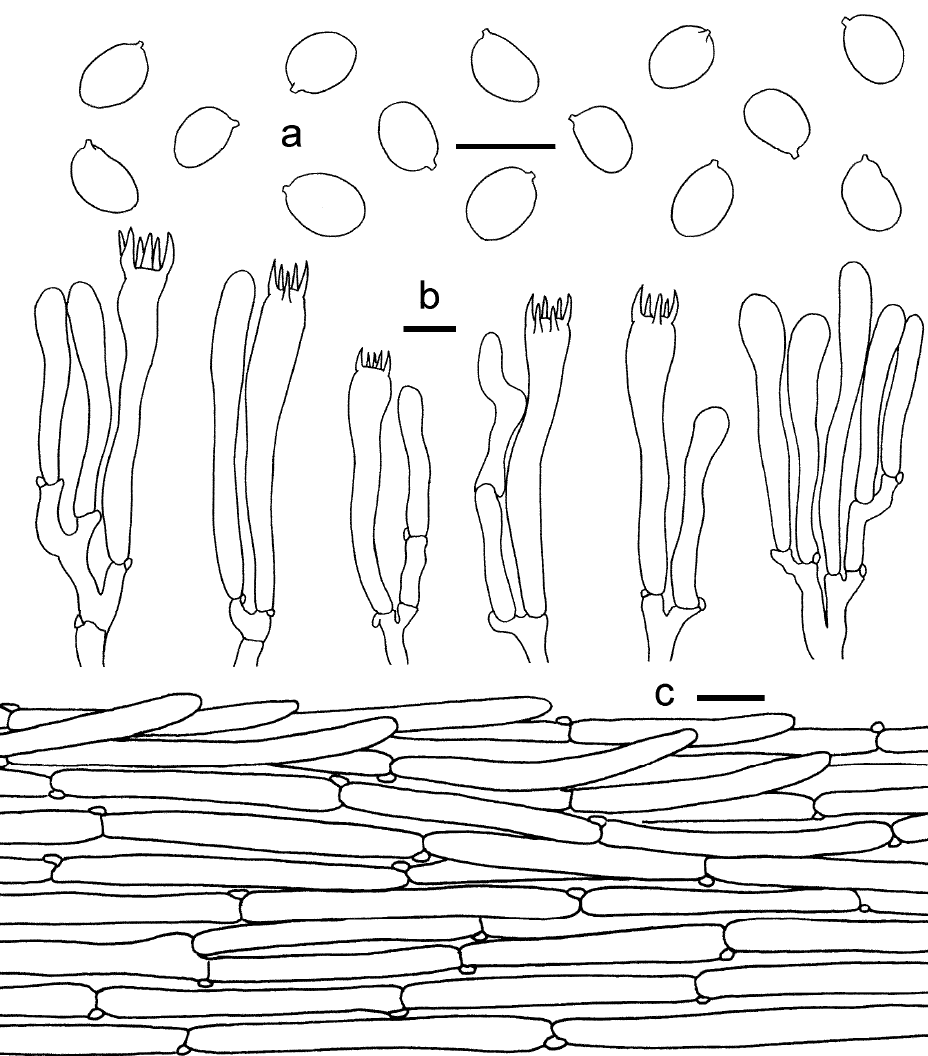
Figure 3. Cantharellus chrysanthus (GDGM80220, Holotype). ( a ) Basidiospores. ( b ) Basidia, basidiola and elements of the subhymenium. ( c ) Pileipellis. Bars: ( a , b ) = 10 μ m; ( c ) = 20 μ